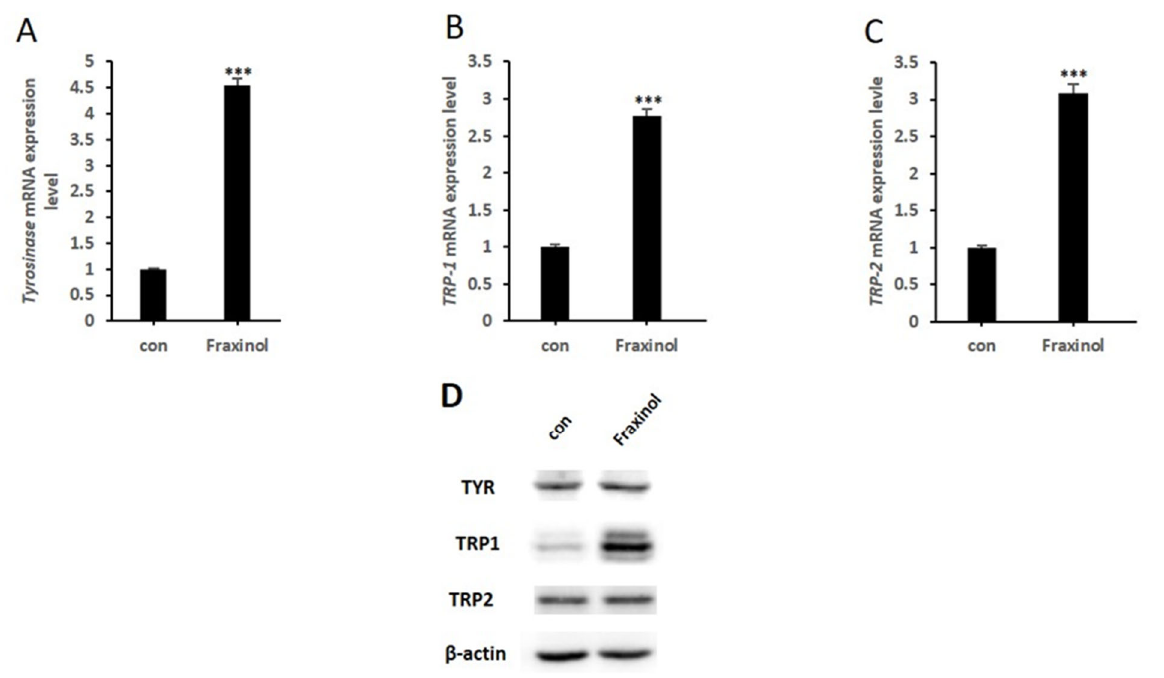
Figure 3. Effects of fraxinol on mRNA and protein expression of tyrosinase, TRP ‐ 1, and TRP ‐ 2. B16 ‐ F10 cells were treated with fraxinol (100 μ M). ( A ) TYR , ( B ) TRP ‐ 1 , and ( C ) TRP ‐ 2 mRNA levels were determined using qRT ‐ PCR. ( D ) Tyrosinase, TRP ‐ 1, and TRP ‐ 2 protein levels were determined using western blotting. The data are presented as the means ± SD; n = 2. *** p < 0.001 compared to the control (no treatment).